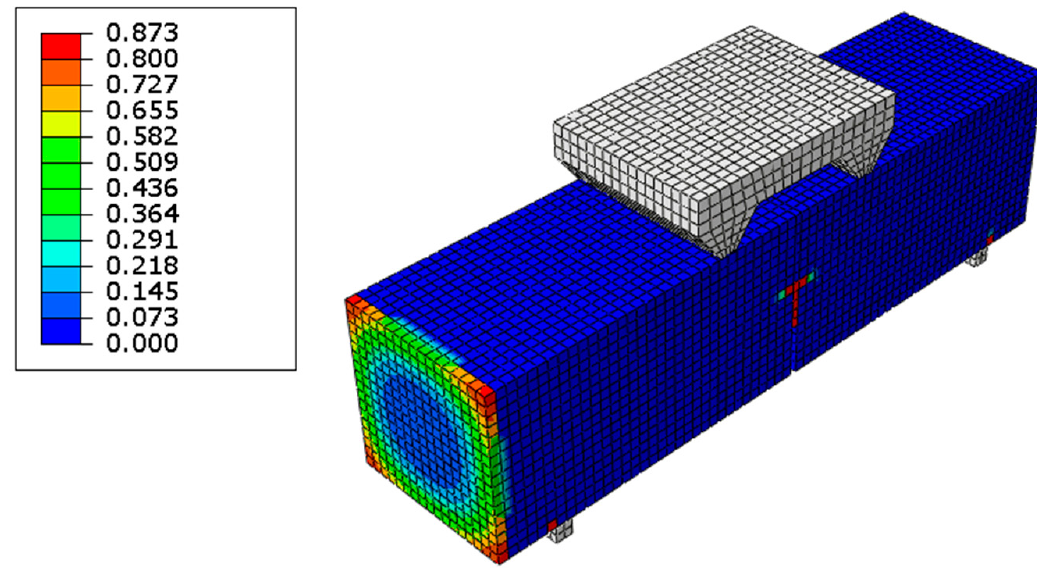
Figure 20. Numerical simulation of flexural damage of the specimen.